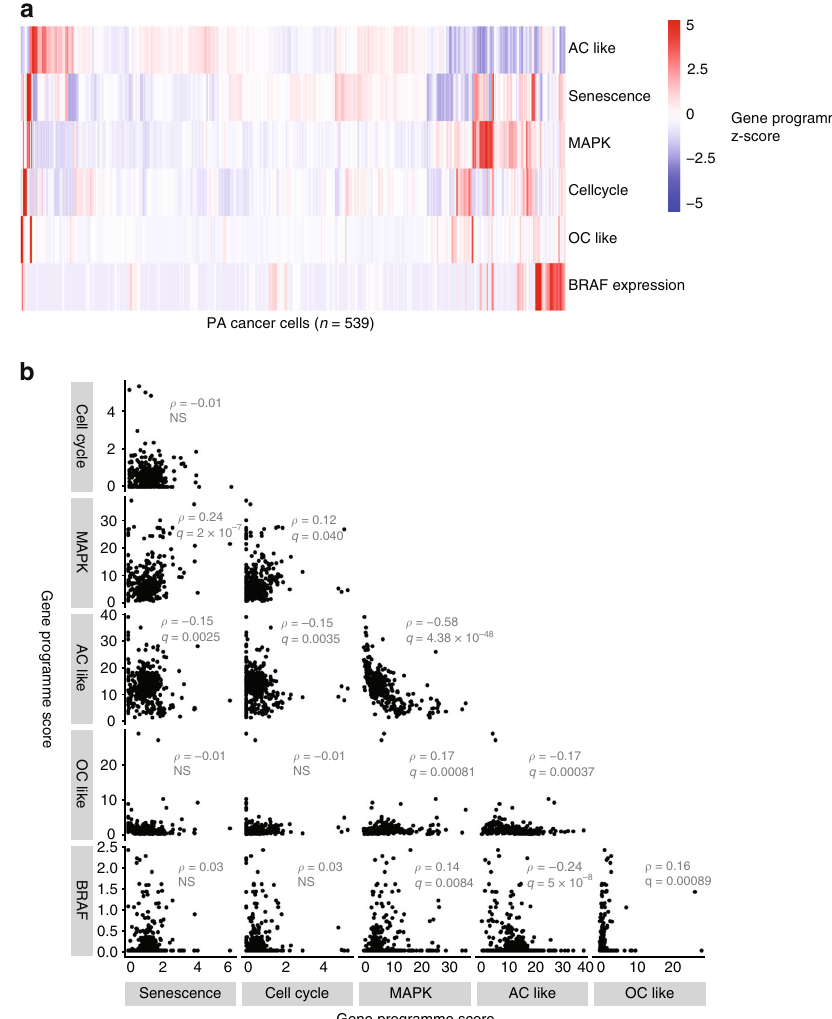
Fig. 8 Relationship between senescence, cell cycling, MAPK, and glia-like programme in PA cancer cells. a Heat map showing ( n = 539) PA cancer cells as columns. Rows show lineage score, MAPK signaling gene programme score, cell cycle score, or senescence score, or BRAF expression. Data are row-scaled and arranged by unsupervised hierarchical clustering. b Plots showing indicated signature scores for PA cancer cells ( n = 539). Each panel on the bottom left shows a pair of signature scores and/or BRAF expression values. Signature scores are represented as fold-enrichment scores (i.e., mean increase in expression of genes in the signature divided by mean expression of all expressed genes). BRAF expression is log-normalized read counts. Spearman ρ and Bonferroni-corrected q-values are shown for each